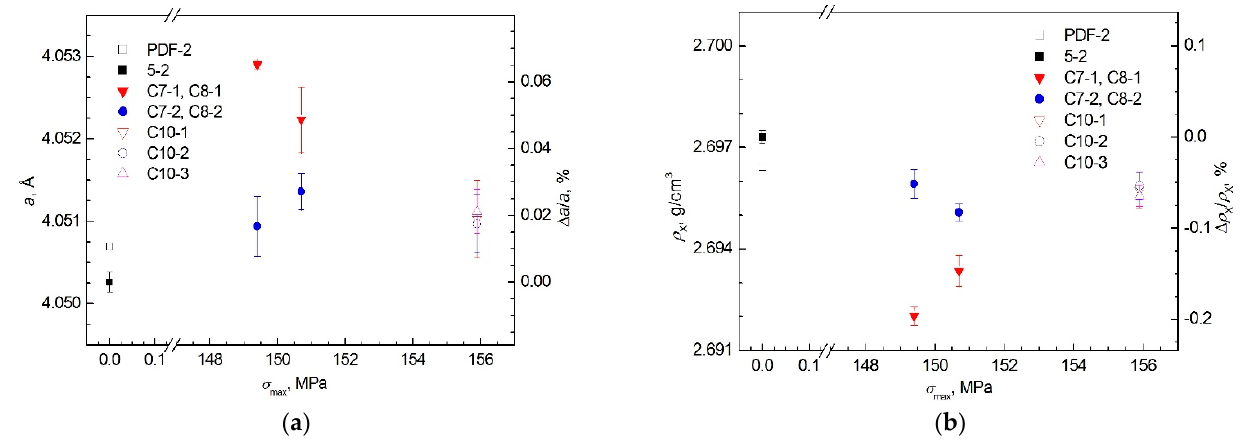
Figure 5. ( a ) Average parameter a of the cubic unit cell and ( b ) average XRD mass density ρ X of the Al material of the near-surface layer with a thickness of ≈ 36 μ m of the samples after cyclic loading as a function of the applied maximum load σ max . The right ordinates show the values of ( a ) the defect Δ a / a of the unit cell parameter and ( b ) the defect of the XRD density Δ ρ X / ρ X , where Δ a = a − a 0 and Δ ρ X = ρ X − ρ X0 , a 0 and ρ X0 are, respectively, the unit cell parameter and XRD density of unused sample 5-2 not subjected to cyclic loading. The designation “PDF-2” in ( a , b ) corresponds to the data of the powder database map PDF-2 01-071-4008 [26] at a temperature T = 312.3 K, which is close to the XRD-measurement temperature T = 314 ± 1 K.